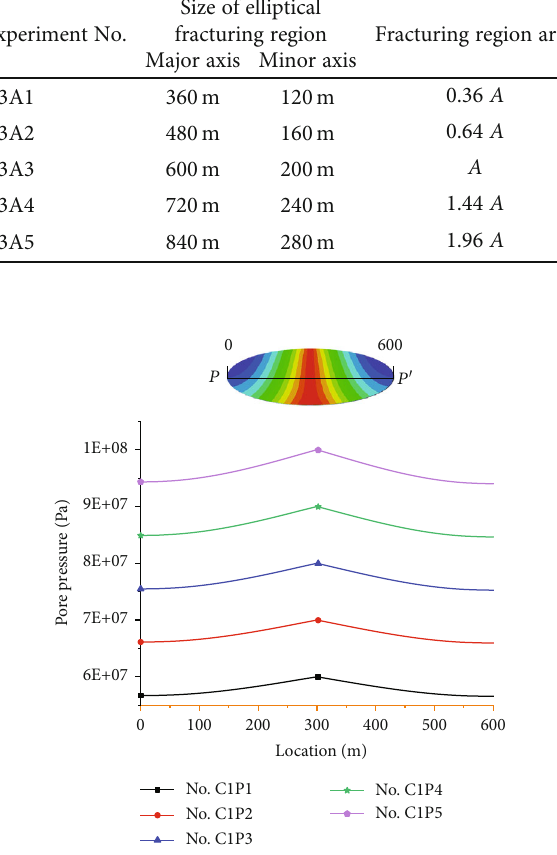
Figure 19: Pore pressure pro fi les along the long axis of region N1 (PP ′ ) of di ff erent injection pressures (Nos. C1P1-C1P5).